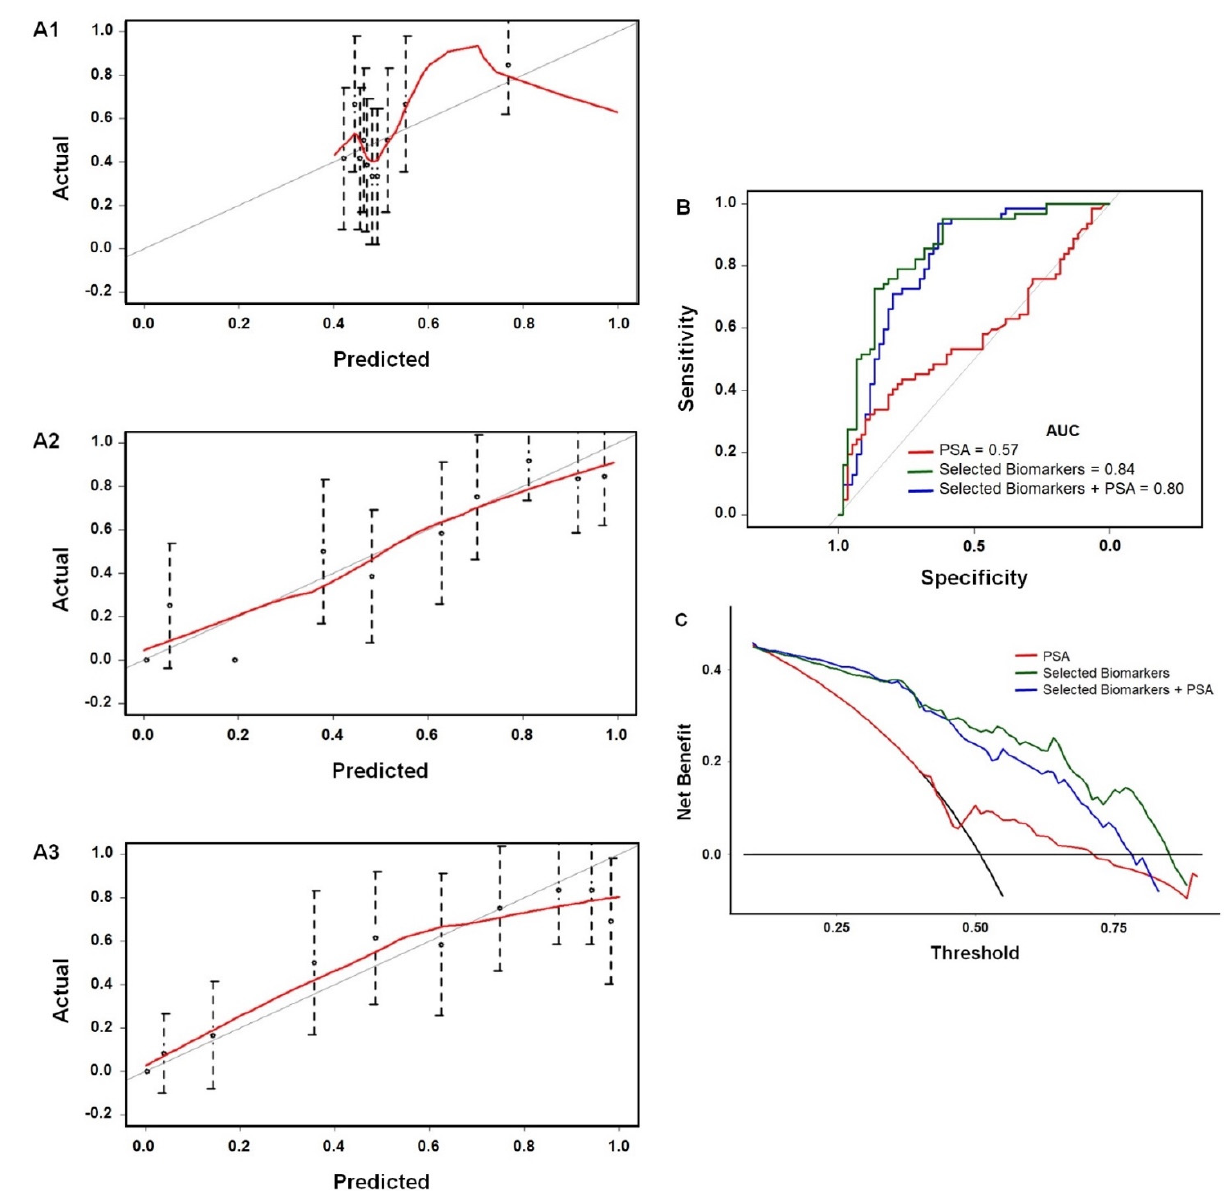
Figure 6. Calibration plots, ROC, and decision curves for predicting need for biopsy. Calibration plots illustrate predicted probabilities on the x-axis and the actual outcome on the y-axis ( A1 ) PSA alone, ( A2 ) selected biomarkers + PSA, model 2, and ( A3 ) selected biomarkers, model 3. ( B ) ROC plot and AUC values of the biomarkers at each risk threshold, for the best model PSA + selected biomarkers. sensitivity and specificity are both 79%; ( C ) decision curves showing the net benefit of treating all patients or treating none vs. threshold probability. Reproduced from [34], copyright American Chemical society, 2021.